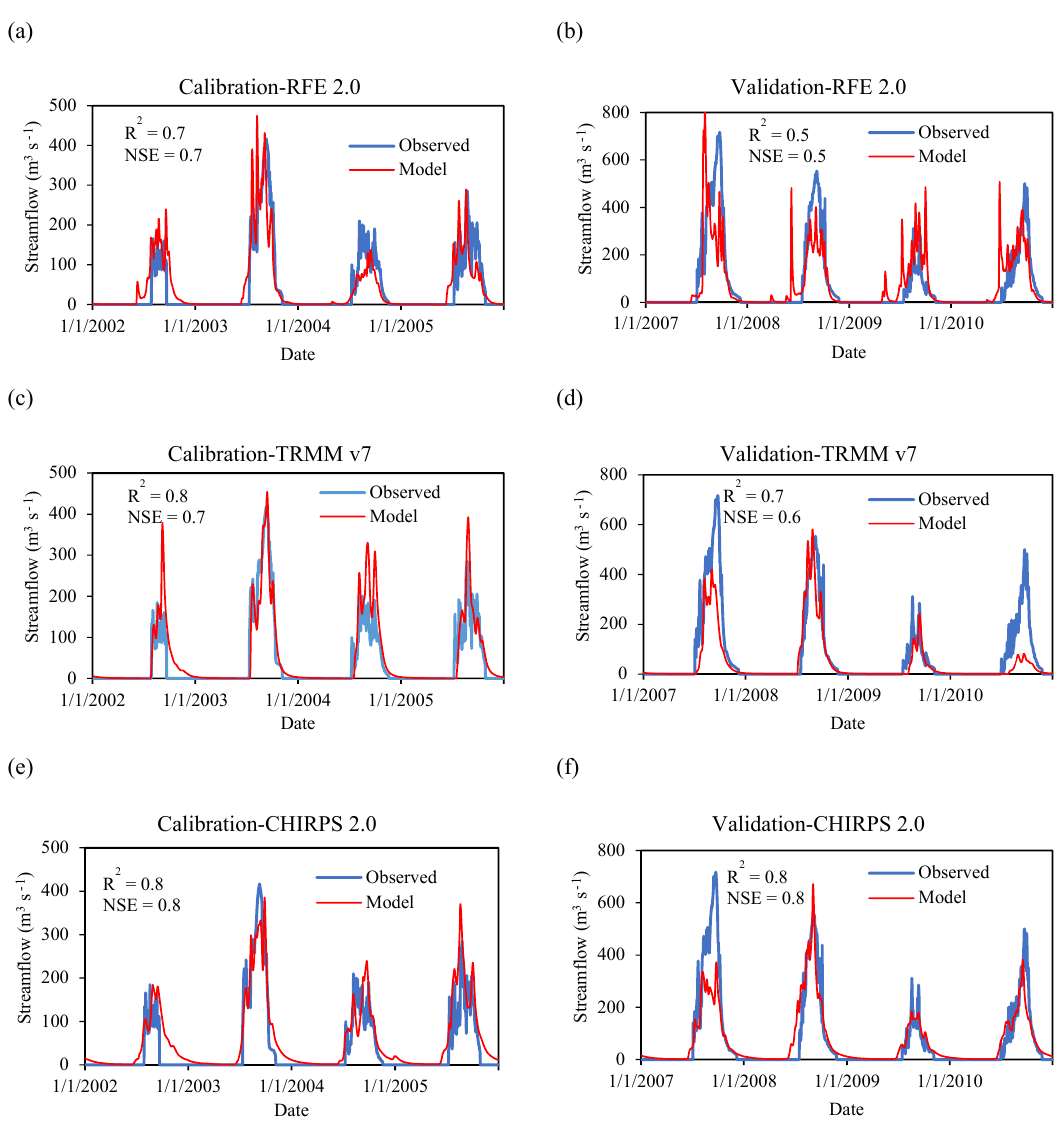
Figure 6. Calibration and validation results at Al Gewisi station on Dinder River (a) and (b) for RFE, (c) and (d) for TRMM and (e) and (f) for